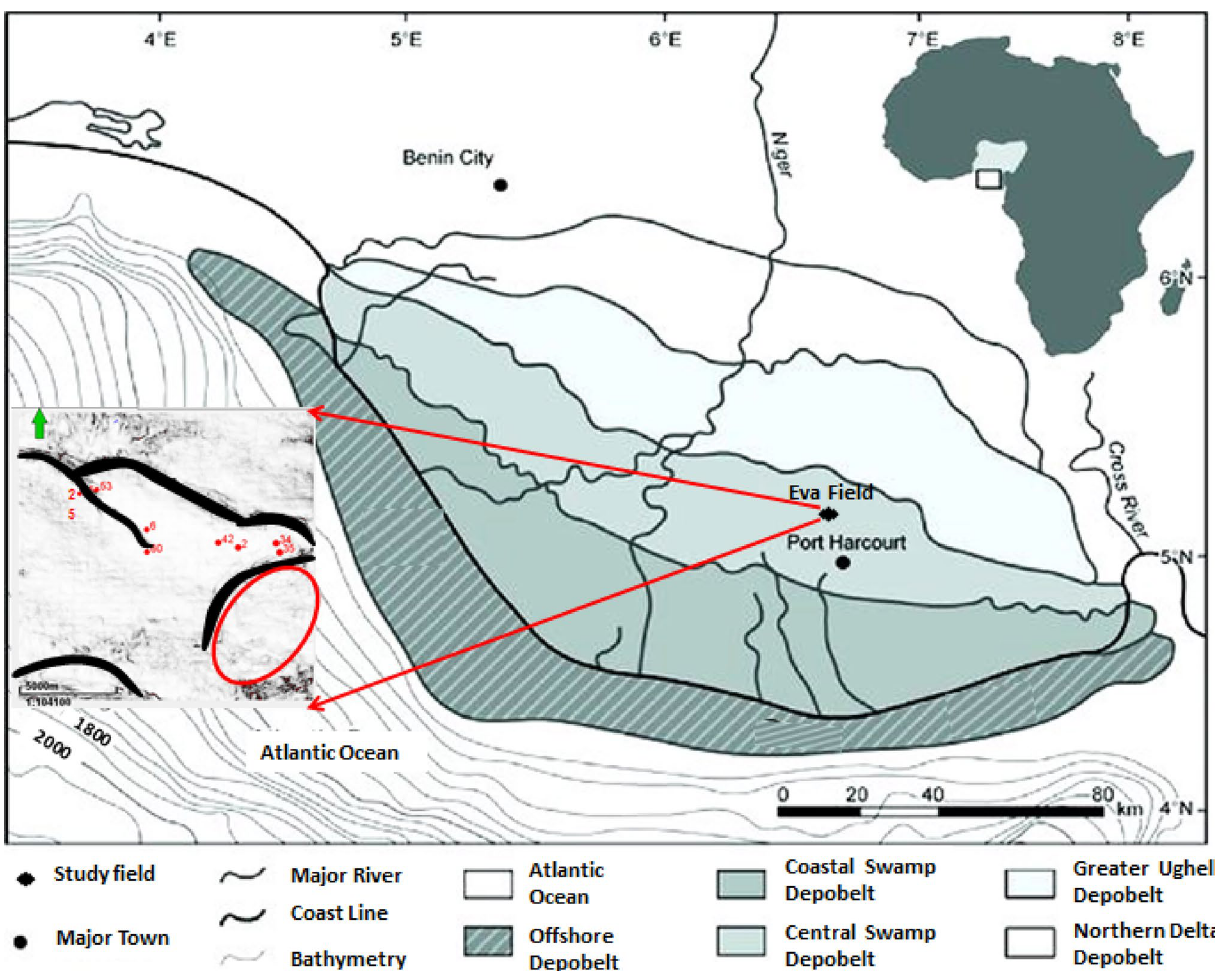
Fig. 1 Map of the Niger Delta Basin showing the various depo-belts, location of the prospective zone of the study Eva field (Modified after Ado- joh et al.